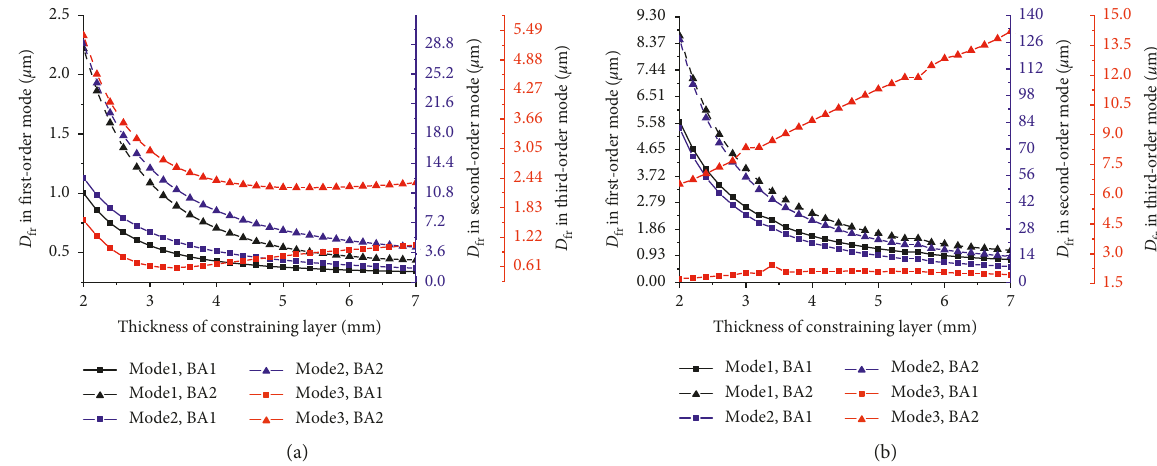
Figure 11: Displacement deviation between foundation and constraining layers in the position of the face plate. (a) Position I, lower constraining layer. (b) Position II, lower constraining